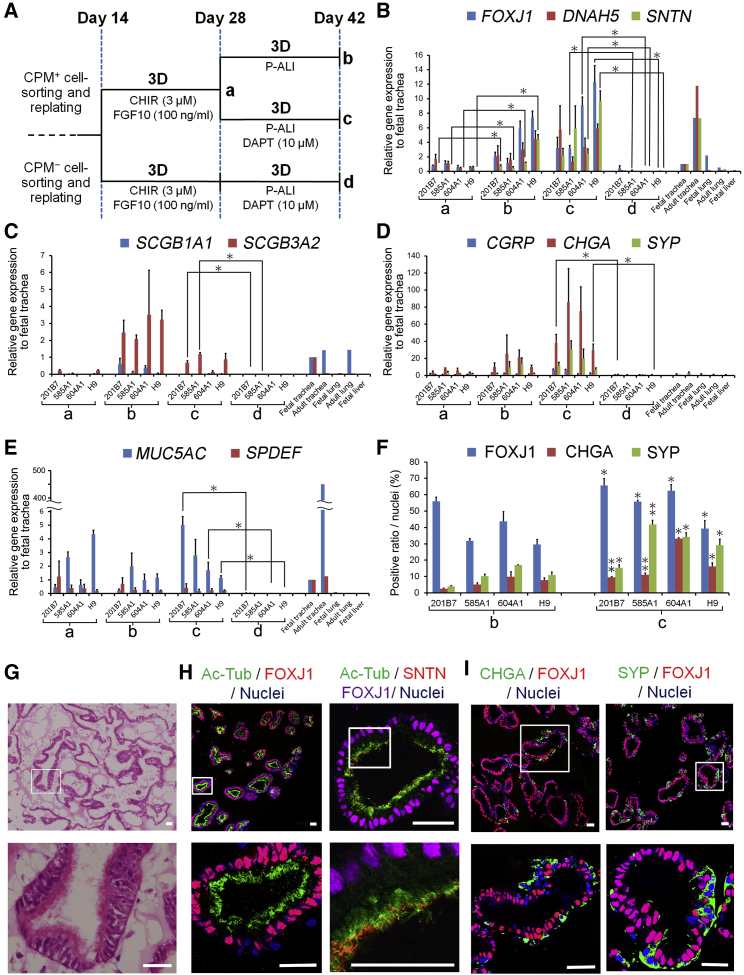
Directed Induction of MCACs and PNECs by Adding DAPT(A) A schematic illustration of each protocol for induction of PAECs, according to CPM-based sorting and the addition of DAPT.(B–E) qRT-PCR of representative PAEC markers: FOXJ1, DNAH5, and SNTN for MCACs (B), SCGB1A1 and SCGB3A2 for club cells (C), CGRP, CHGA, and SYP for PNECs (D), and MUC5AC and SPDEF for mucus-producing cells (E). Each value was normalized to β-ACTIN. The gene expression of the fetal trachea sample was set at 1. Error bars represent the mean ± SEM (n = 3 independent experiments; ∗p < 0.05).(F) The induction efficiency of MCACs and PNECs calculated by counting the number of FOXJ1+, CHGA+, and SYP+ cells (Supplemental Experimental Procedures). Error bars represent the mean ± SEM (n = 3 independent experiments). Protocol c was compared with protocol b for each hPSC line; ∗p < 0.05, ∗∗p < 0.01.(G) H&E staining of DAPT-induced 3D spheroids (201B7 hiPSCs) on day 56 (upper panel) showed consecutively aligned MCACs in a magnified view (lower panel).(H) Double and triple immunostaining of MCAC markers in DAPT-induced PAEC spheroids (201B7 hiPSCs) on day 56. Magnified views were shown in lower panels.(I) Double immunostaining of CHGA or SYP (PNEC markers) with FOXJ1 in DAPT-induced PAEC spheroids (201B7 hiPSCs) on day 56. None of the markers was expressed in FOXJ1+ cells.Scale bars, 25 μm. See also Figure S3 and Tables S1 and S2.